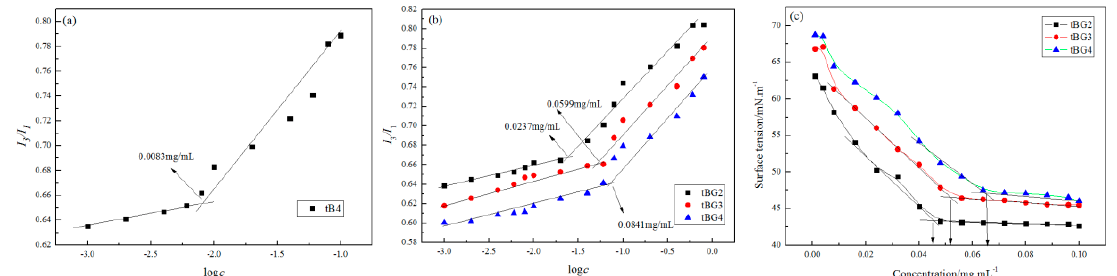
Figure 5. The critical micelle concentration (CMC) of the copolymer tB4 ( a ); the CMC of copolymer tBG2, tBG3, and tBG4 measured by fluorescence spectrometer ( b ); and the CMC of copolymers tBG2, tBG3 and tBG4 measured by the surface tension method ( c